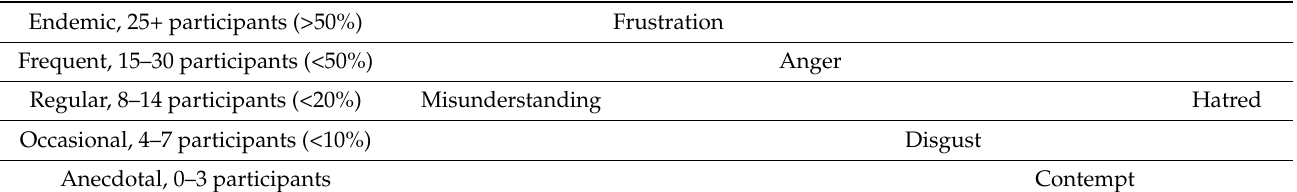
Table 3. Emotional cycle and